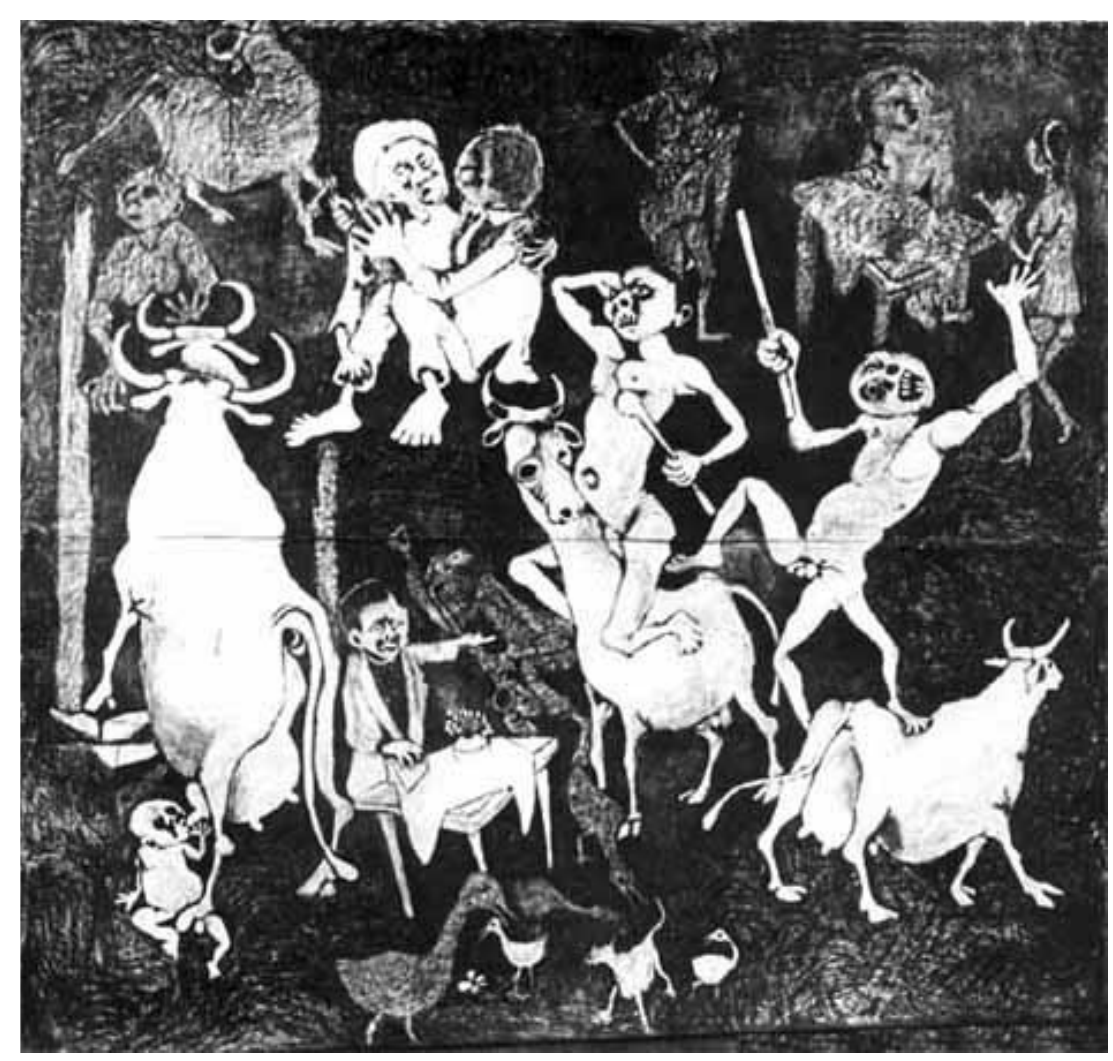
Figure 1 : Dumile Feni, African Guernica, (1967) Confronting this observation, as it was inaugurated by segregationist laws, Feni’s work is useful for three reasons. In the first instance, Feni (1967) addresses the question of the deracination of Black/Indigenous life. His project in this artistic work refocuses the principle question that is guiding my analysis; how do we arrive at justice? The reader should recall the predefining propositions that lead to the question of justice, this being the proposition of epistemic access as a medium that facilitates justice. The question of justice re- centres Paton’s (1957: 73) vexing oeuvre that delivers the punch-line of his novel through his